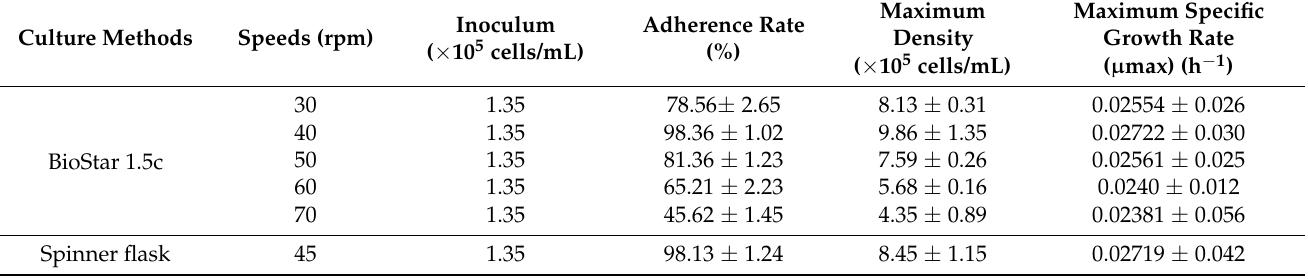
Table 2. Effects of the two culture methods on the proliferation of hUCMSCs.